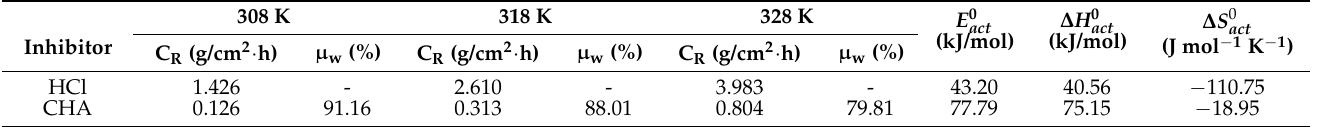
Table 1. The values of the corrosion rate and inhibitory efficiencies at different temperatures, as well as the kinetic parameters of